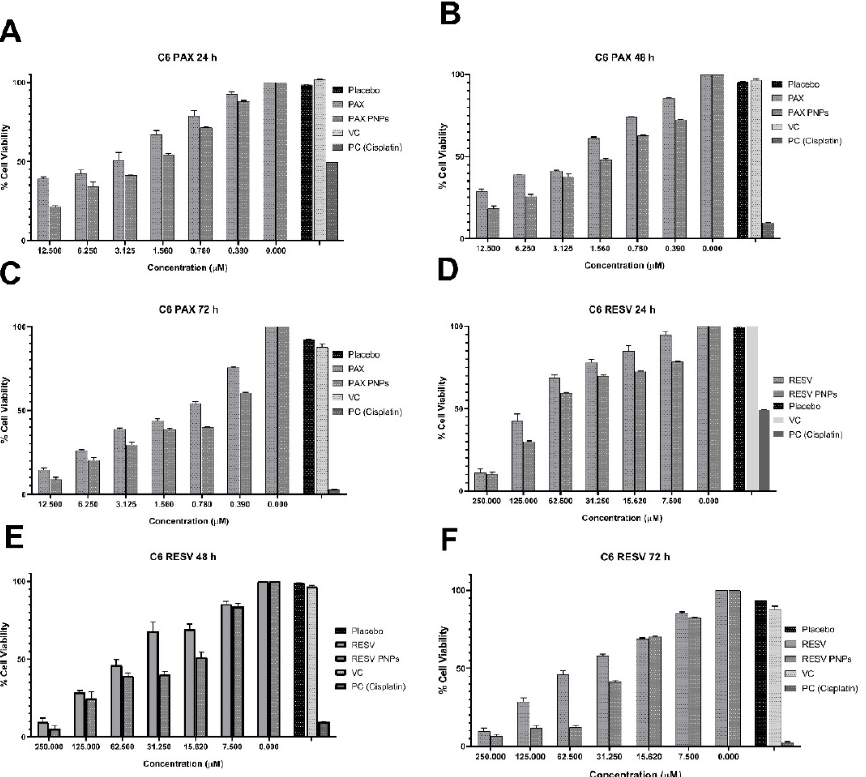
Figure 6. In vitro Cytotoxicity of free PAX and PAX PNPs ( A ) (24 h), ( B ) (48 h), and ( C ) (72 h) of C6 cell lines. In vitro Cytotoxicity of free RESV, and RESV PNPs ( D ) (24 h), ( E ) (48 h), and ( F ) (72 h) on C6 cell lines. Data represent the mean ± standard deviation ( n = 3).